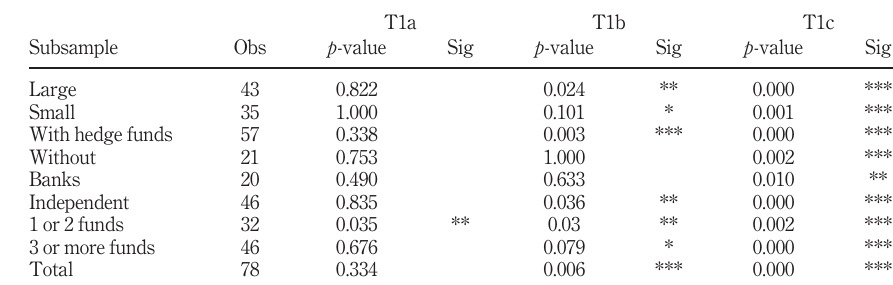
Table V. Results of H1 chi- square tests on